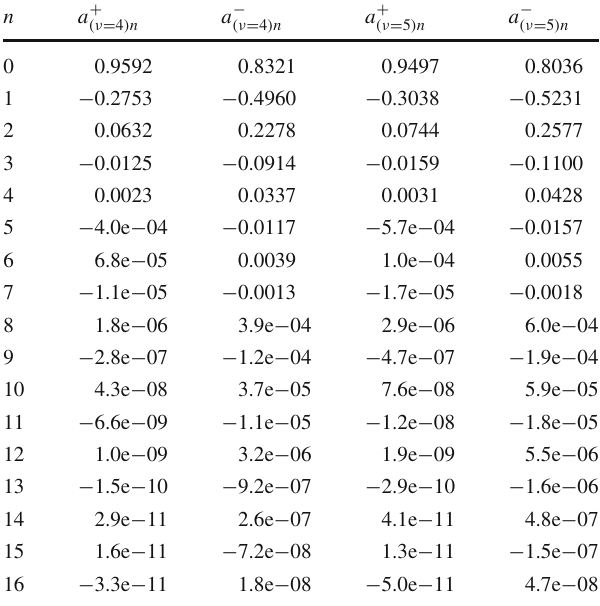
Table 3 The numerical values of the coefficients a ± ν n for the variational expansion (14) in the case of maximum h.o. quanta n max = 16 and ν = 4 ( l + = ν = 4, l − = ν + 1 = 5 and ν = 5 ( l + = ν = 5, l − = ν + 1 = 6). The h.o. constants are fixed by the